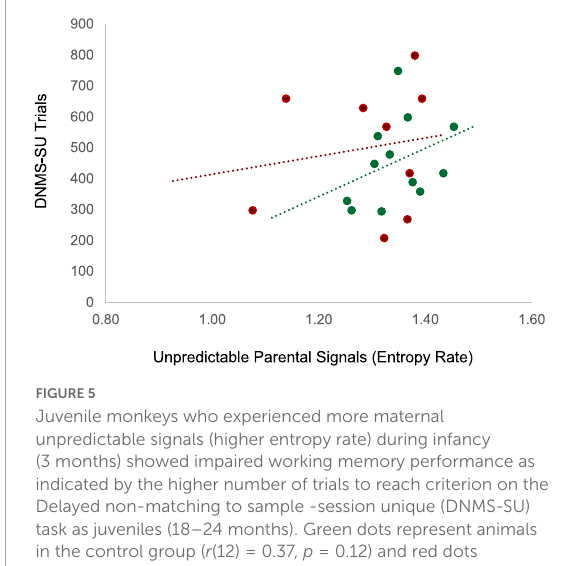
FIGURE5 Juvenile monkeys who experienced more maternal unpredictable signals (higher entropy rate) during infancy (3 months) showed impaired working memory performance as indicated by the higher number of trials to reach criterion on the Delayed non-matching to sample -session unique (DNMS-SU) task as juveniles (18–24 months). Green dots represent animals in the control group ( r (12) = 0.37, p = 0.12) and red dots represent animals in the maltreatment group ( r (9) = 0.16, p =